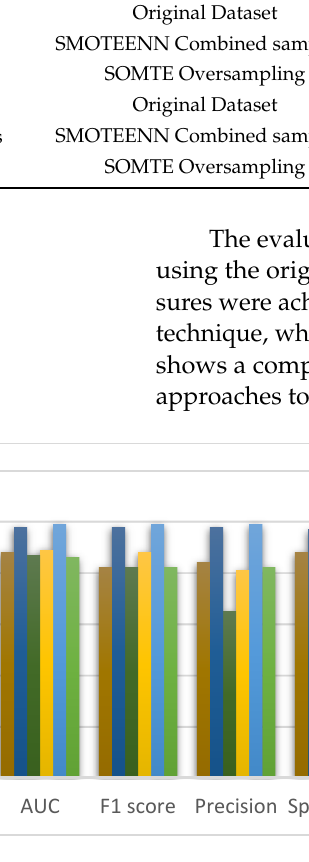
Figure 8. Evaluation measures for the full model and the selected features model, using the original dataset and two data sampling techniques.